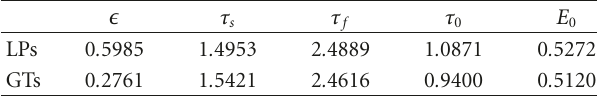
Table 3: The expectations over time of the parameter estimates from ROIs with the presented nonlinear filtering algorithm.